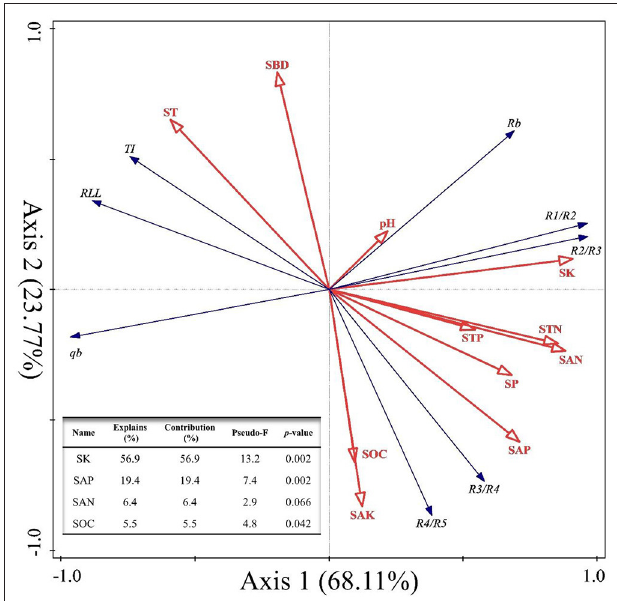
FIGURE 5 | Redundancy analysis (RDA) of root system architecture (RSA) and soil physicochemical properties at the four different sites. RSA variables are TI, topological index; q a and q b , revised-topological index; RLL, root link length; R b , root branching rate; R i :R i + 1 , gradual root branching rate. The soil parameters are SW, soil water content; SBD, soil bulk density; SP, soil porosity; pH, soil pH; SOC, soil organic carbon; STN, soil total nitrogen; STP, soil total phosphorus; SK, soil total potassium; SAN, soil available nitrogen; SAP, soil available phosphorus; SAK, soil available potassium. The angle between the two vector arrows can represent a significant and positive relationship (acute angle, < 90 ◦ ) or a negative relationship (obtuse angle, > 90 ◦ ). The length of each arrow is proportional to the magnitude of the standardized path coefficients (i.e., the strength of the